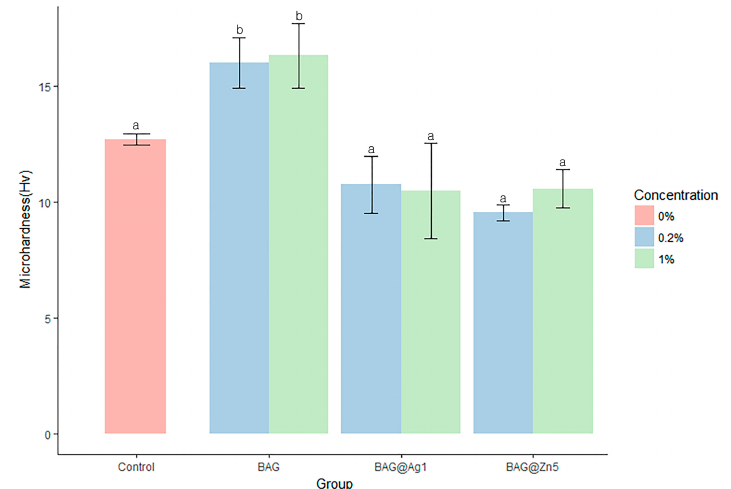
Figure 2. Comparison of the microhardness of the BAG and ion-doped BAG orthodontic bonding primer. Error bars indicate the ± standard deviation. The same letters indicate that the p -value is not significantly different ( p < 0.05). p < 0.05 using Duncan’s Multiple Range Test ( n = 5).